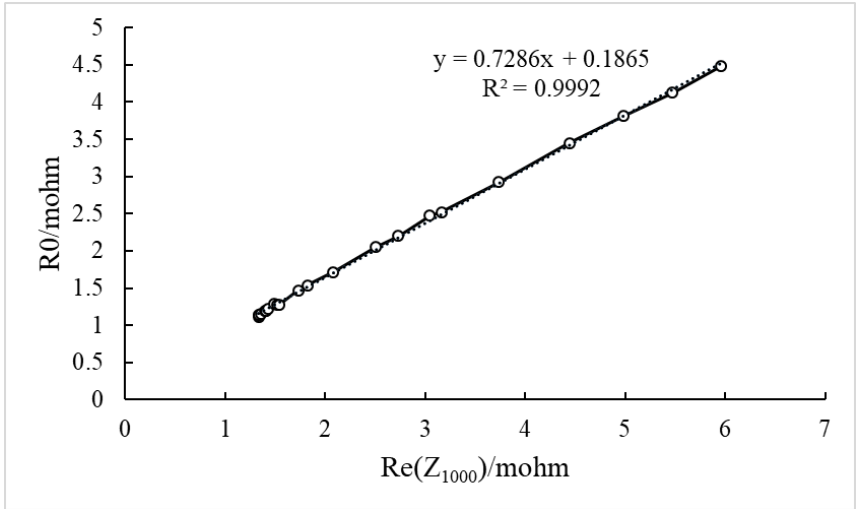
Figure 7. The correlation between Re( Z 1000 ) and R 0 .